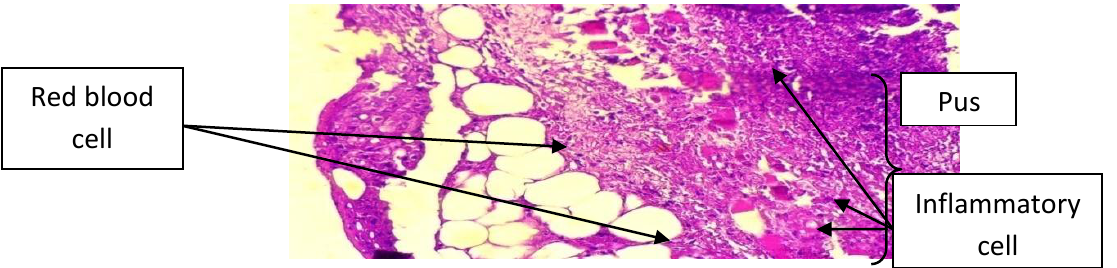
Figure (5): Section of mouse infected by S. aureus treated with Clindamycin (H×E) in 40×-